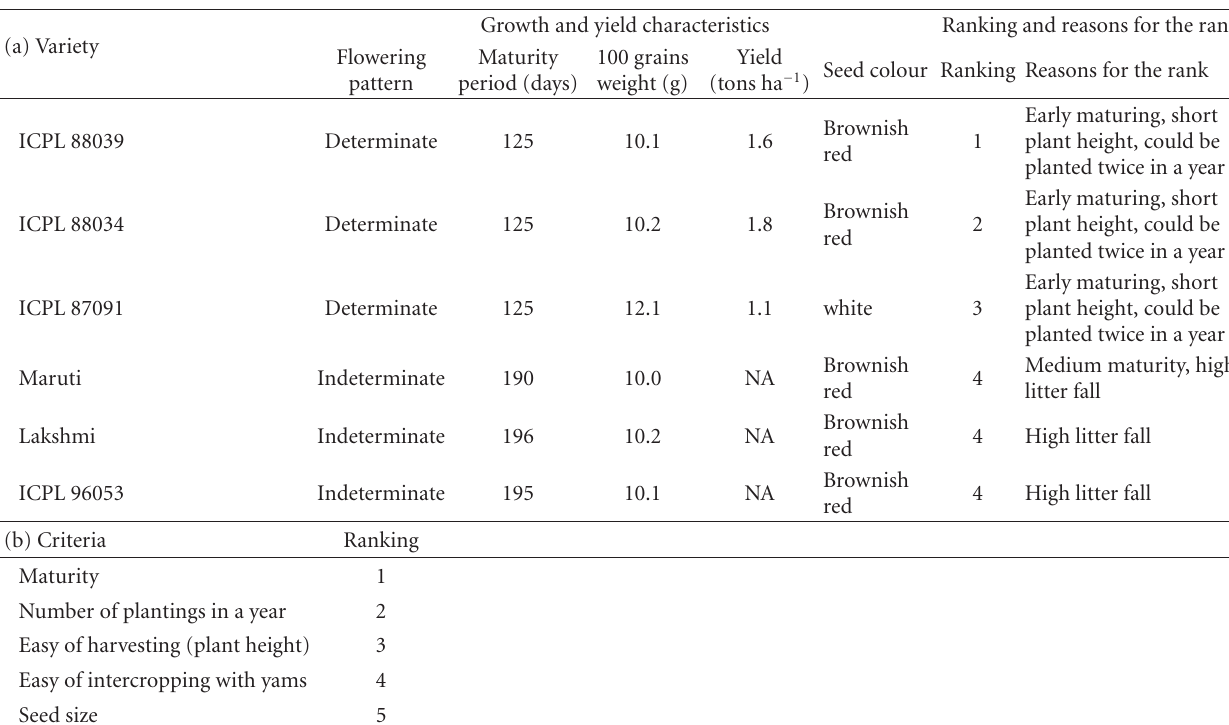
Table 6: (a) Farmers’ preference ranking and (b) farmers’ criteria for selection of pigeonpea varieties for planting. (a)